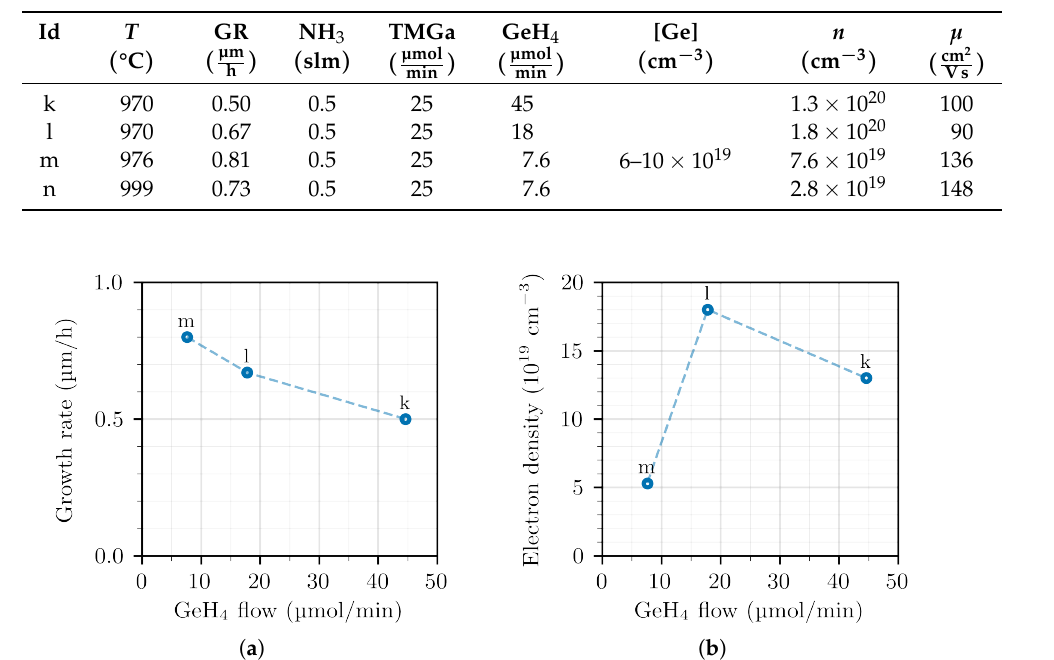
Table 2. Summary of the growth conditions and characterization results of the second series of samples, where the NH 3 flow is reduced to 0.5slm. The [Ge] column shows the concentration of germanium impurities in the test layers as measured by secondary-ion mass spectrometry (SIMS). The n and µ columns show the electron density and mobility from the Hall-effect measurements.